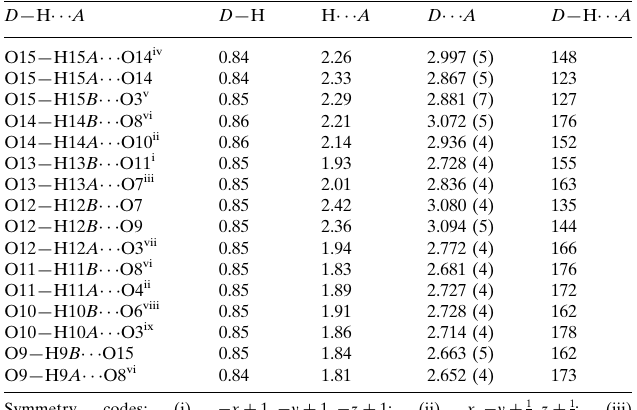
Hydrogen-bond geometry (A˚ , (cid:4)